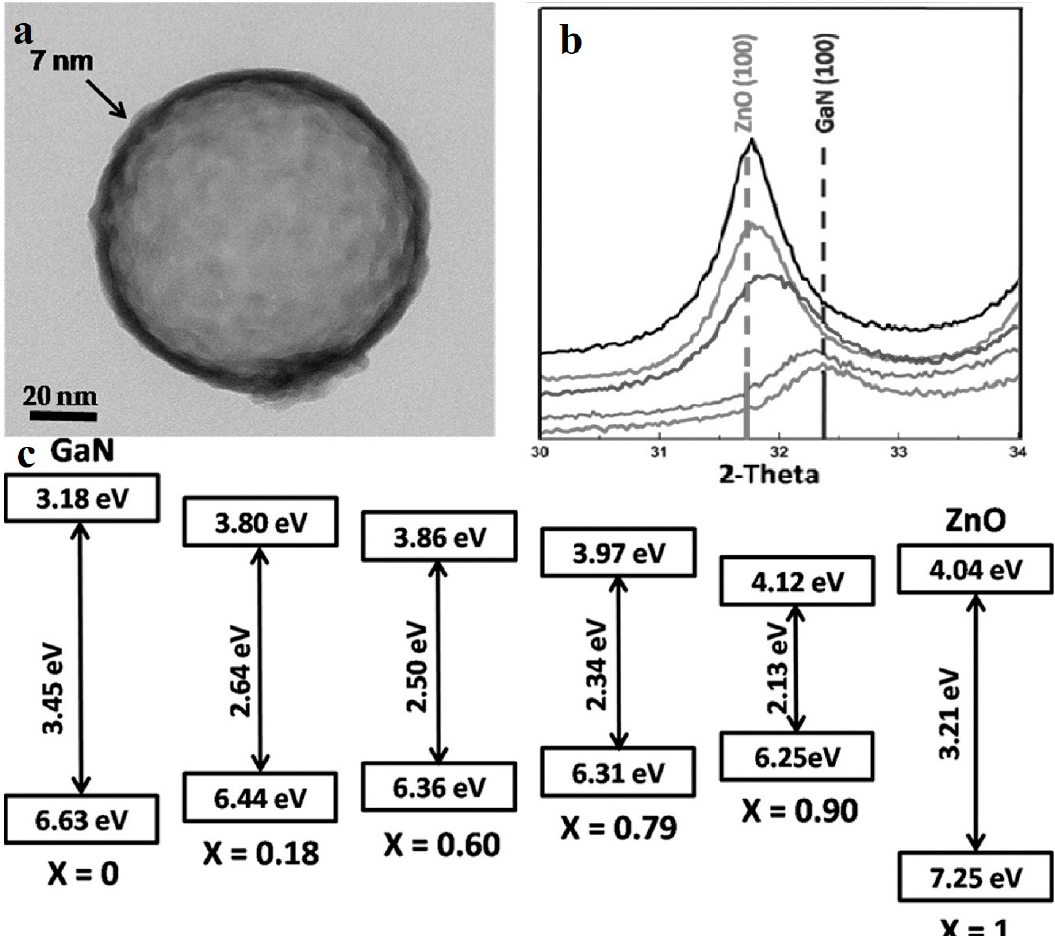
Figure 9. ( a ) TEM image shows an extremely thin shell (about 7 nm) of (Ga 0.82 Zn 0.18 )(N 0.82 O 0.18 ) hollow spheres. ( b ) The (100) peak shift between GaN (100) and ZnO (100) with different x . ( c ) The band